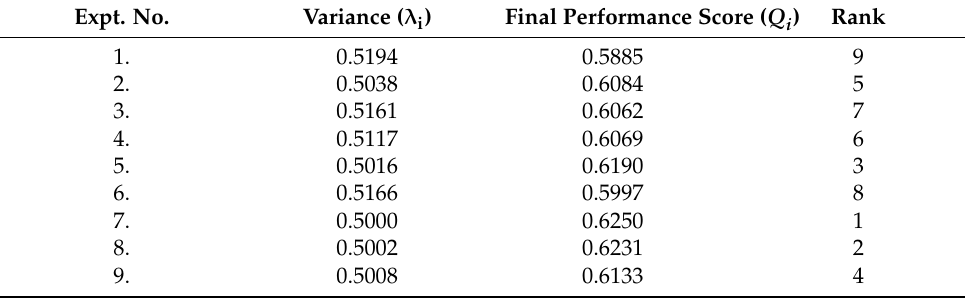
Table 6. λ i , Final performance matrix and